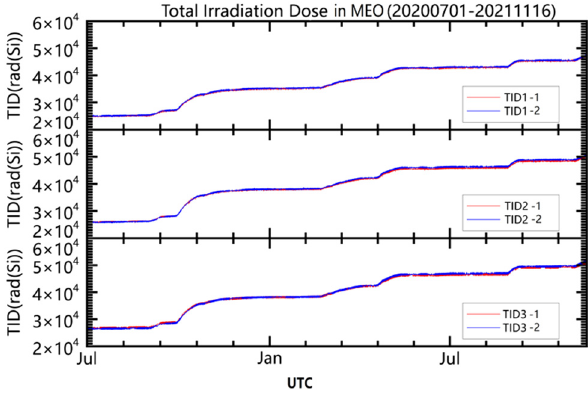
Figure 11: Total radiation dose in three directions in navigation satellite cabin.